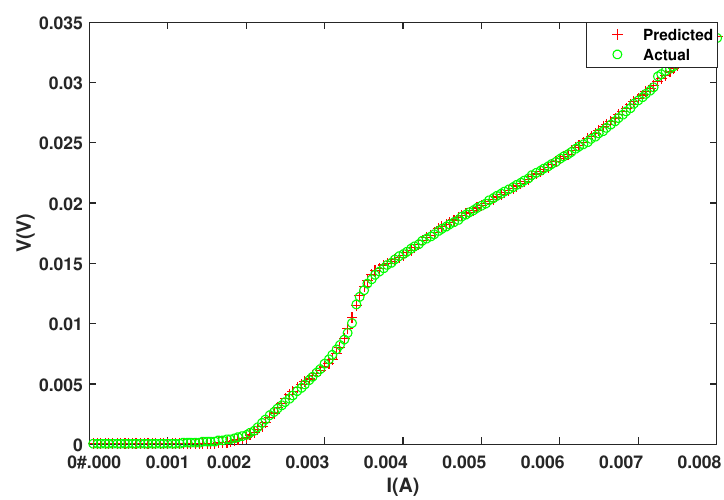
Figure 5. Actual vs. predicted IV curves for temperature = 8.4 K, magnetic field = 100 Oe.